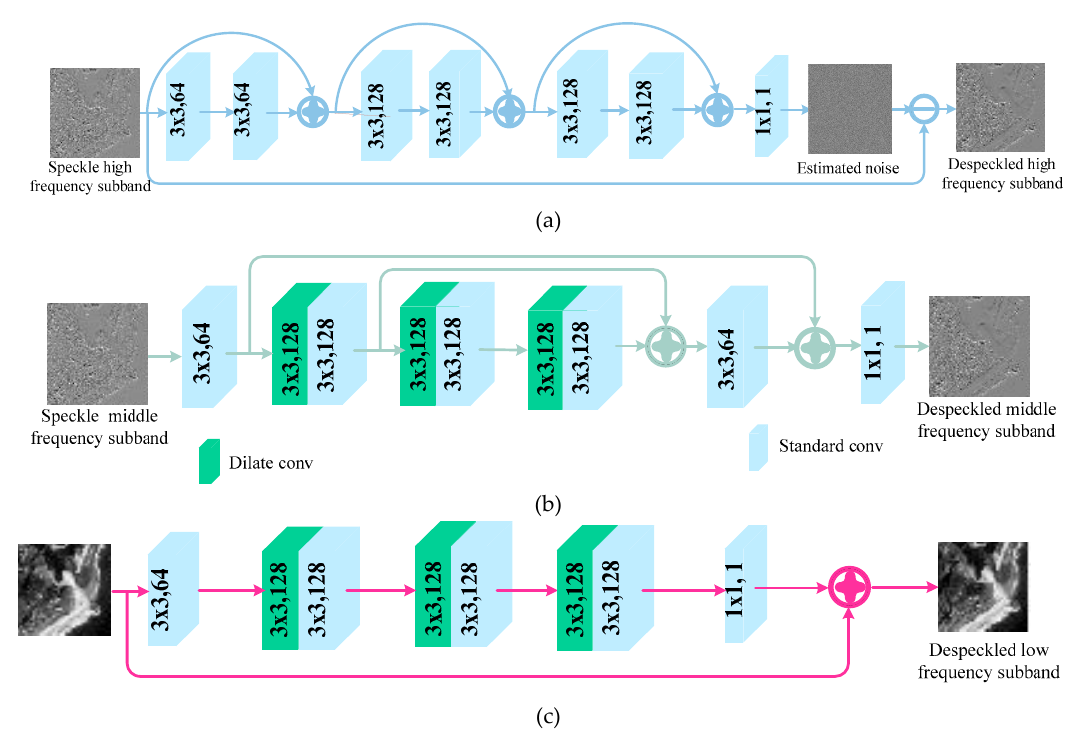
Figure 2. The structure of each subnetwork of the CCNN. ( a ) The subnetwork used to train the directional sub-bands of the first level; ( b ) The subnetwork used to train the directional sub-bands of the second level; ( c ) The subnetwork used to train the coarse sub-band.